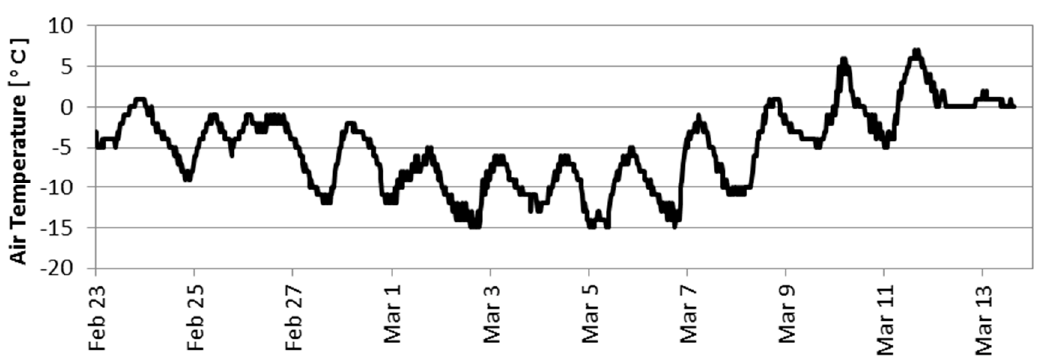
Figure 2. Air temperature recorded in Szczecin airport in February and March of 2018.